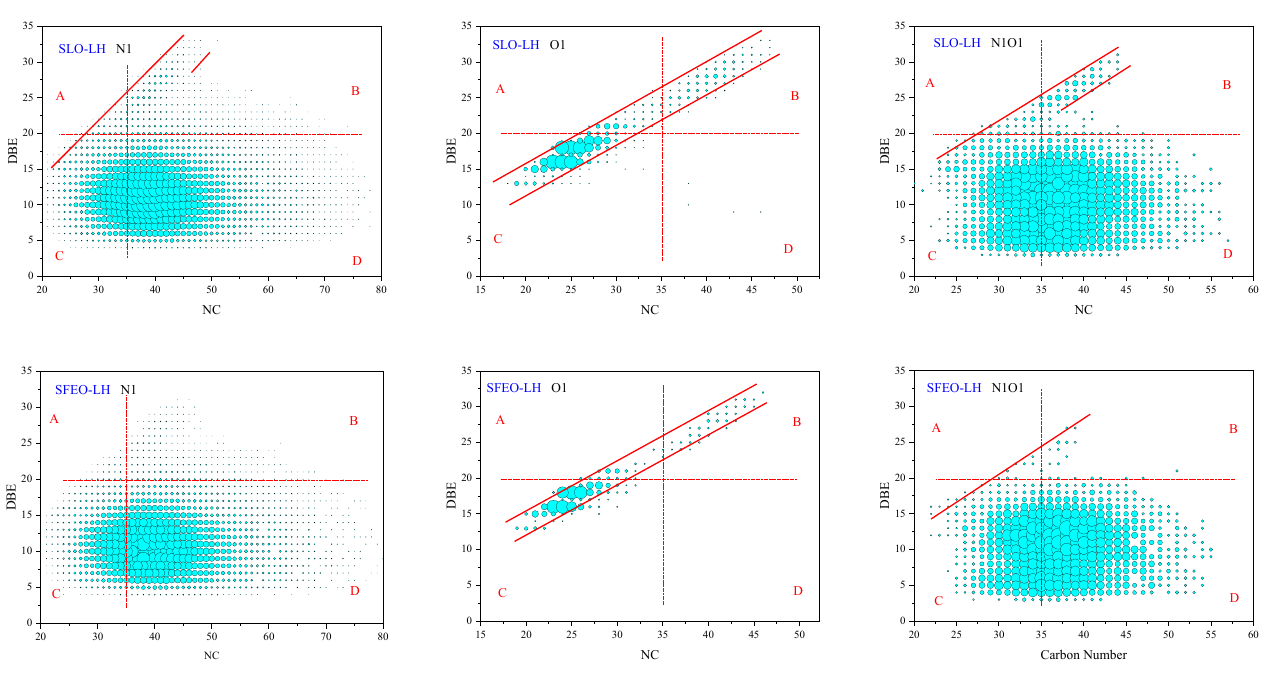
Figure 11. Relative abundance distribution of DBE for three species (N1, O1, N1O1) in SLO and SFEO (+ESI). in Figure 14e. After SFE treatment, the higher degree of condensation of the N1 compound (DBE > 20) was lowered.